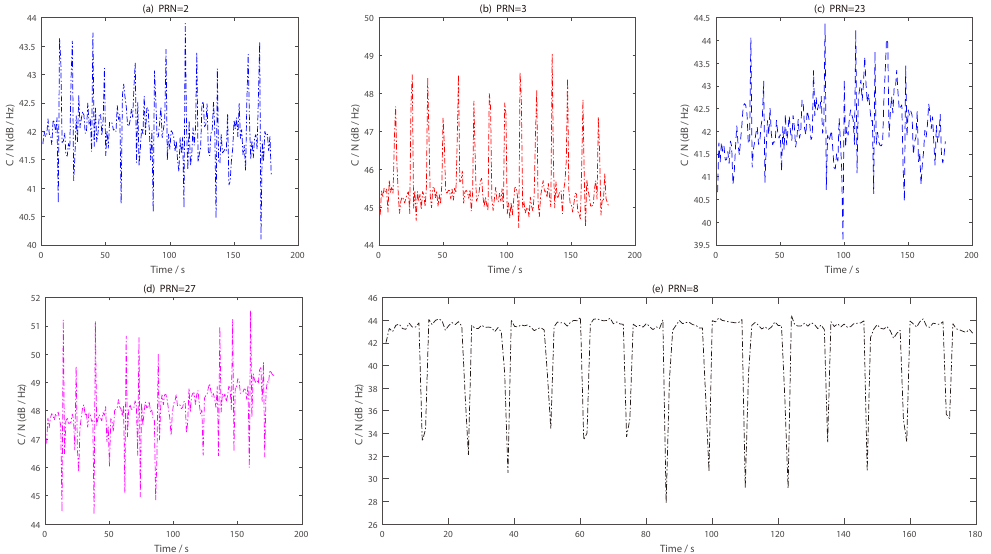
Figure 16. CNR information of five BeiDou satellite reflected signals in the second experiment: ( a ) PRN2 satellite; ( b ) PRN3 satellite; ( c ) PRN23 satellite; ( d ) PRN27 satellite; ( e ) PRN8